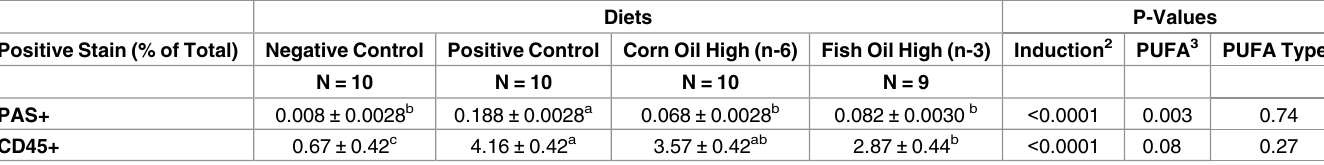
Table 6. Percent of lung tissue staining positive with periodic acid-Schiff (PAS) stain for mucus and rat anti-mouse CD45 stain, after mice were fed (n-3) or (n-6) PUFA enriched foods for 8 weeks and then sensitized and challenged with OVA for an additional 4 weeks compared with mice fed control food that were sensitized and challenged with saline (Negative Control) or OVA (Positive Control) 1 .